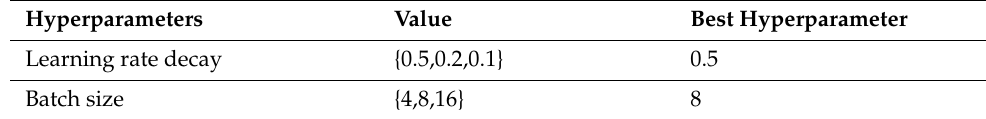
Table 4. Finetune of